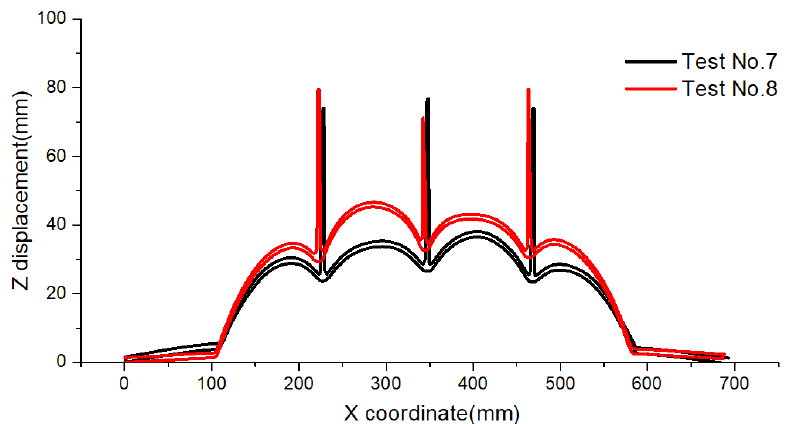
Figure 25. Central H-H section profile of Tests No. 7 and 8.